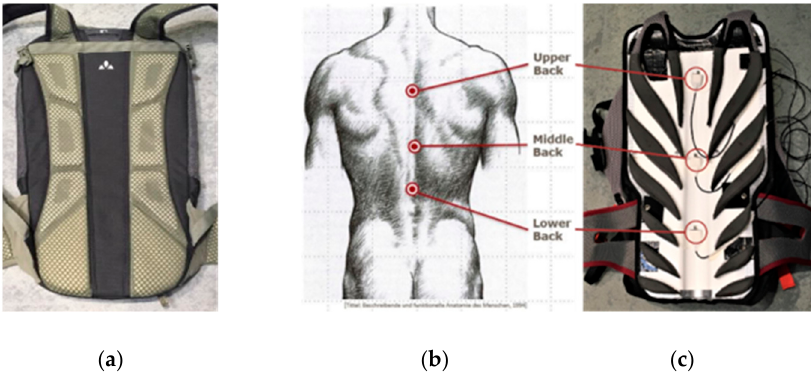
Figure 1. The two types of backpack used in the study: ( a ) conventional backpack; ( c ) backpack having an innovative rear panel design. ( b ) and (c) illustrate the positioning of three combined temperature and humidity sensors placed skin-close (microclimate) along the spine and at corresponding positions on the backpacks (interlayer